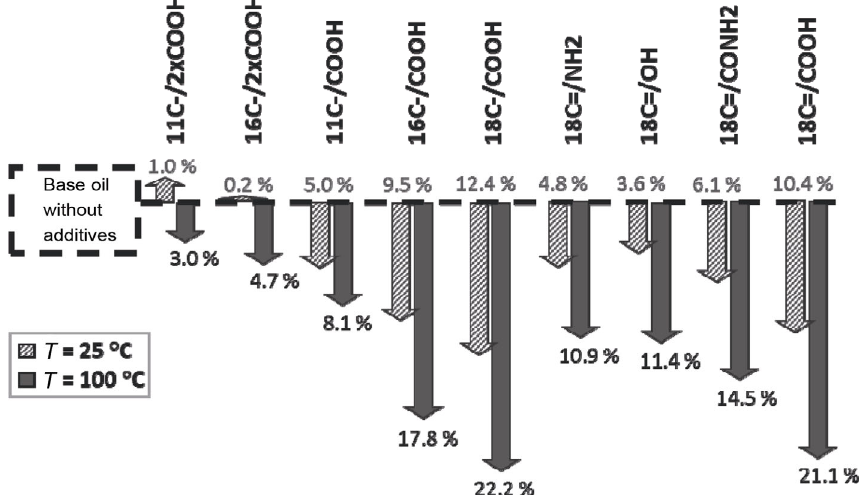
Fig. 4 Average difference in the COF (in %) between the base oil with additive and the base oil without